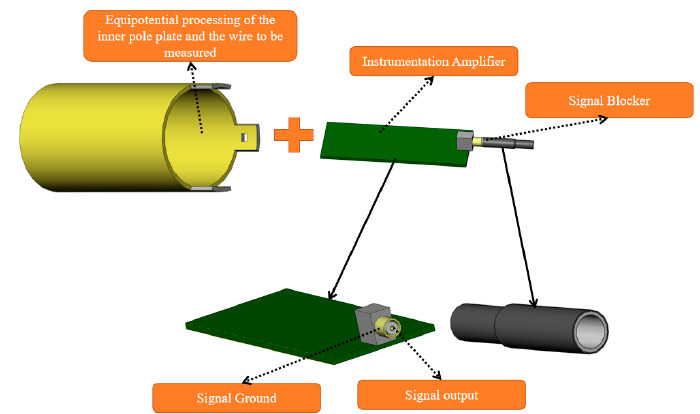
Figure 10. Simulation results of multi-wire diameter and multi-position coupling capacitance.